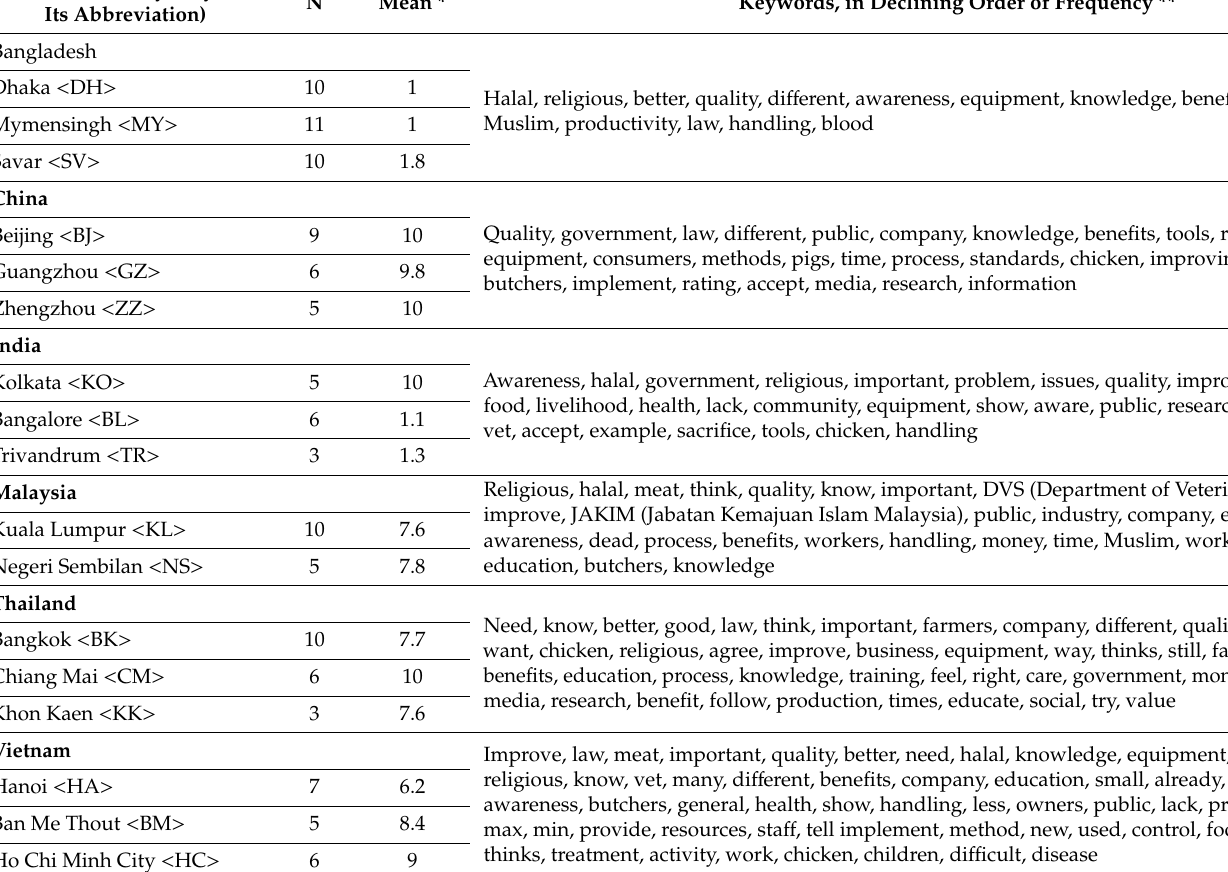
Table 3. Likelihood to adopt stunning, and key themes, by country and region (all stunning data). Keywords, in Declining Order of Frequency